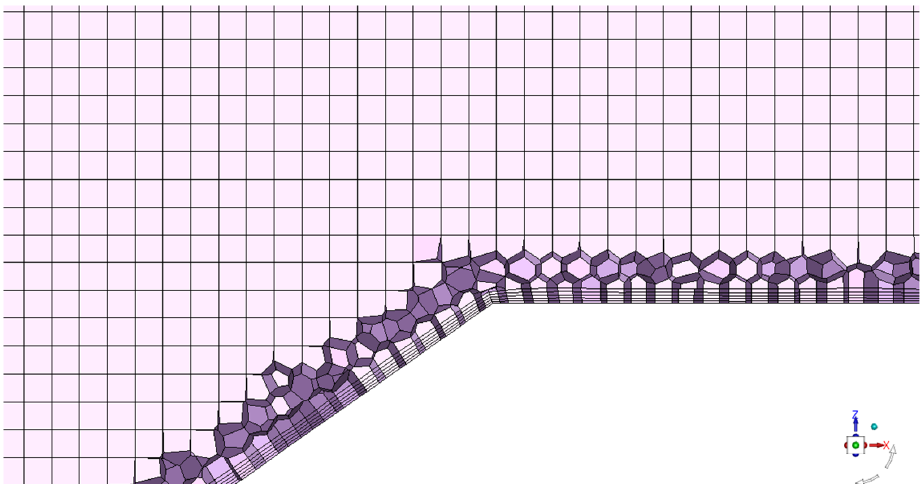
Figure 3. Detailed diagram of the grid boundary layer.